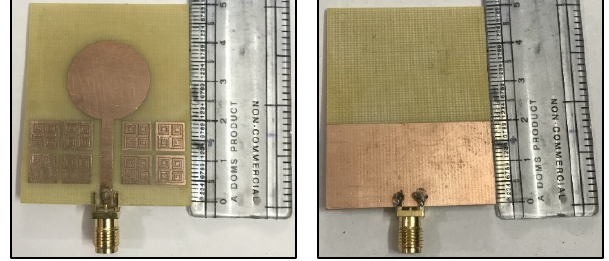
Figure 14. Fabricated UWB-CMSA with spiral EBG near